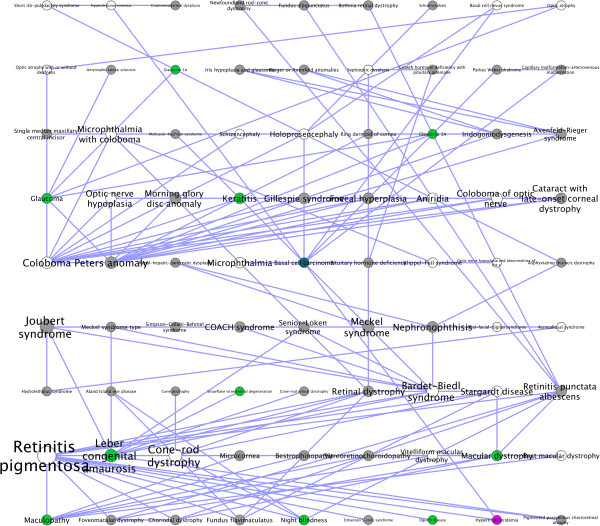
OMIM disease network. The intramodular connections between the nodes of the eye disease cluster are shown. Diseases are colored based on their MeSH categories, with diseases categorized as eye diseases (colored green), diseases linked to multiple categories (colored grey), and diseases that were not found (colored white). Note that more nodes should have been classified into the eye cluster by MeSH based on the name alone. Primary examples of this include retinitis pigmentosa, cone-rod dystrophy, retinal dystrophy, and microcornia. In spite of the failure of green labeling, these nodes were correctly classified by CPBA. Node and font sizes are proportional to a disease’s propensity.